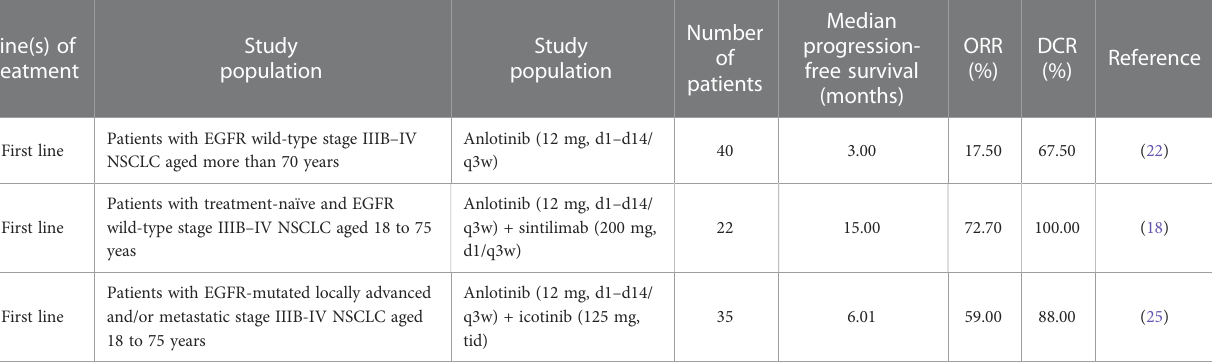
TABLE 2 Some clinical trials of anlotinib in non-small cell lung cancer (NSCLC) for the fi rst line.